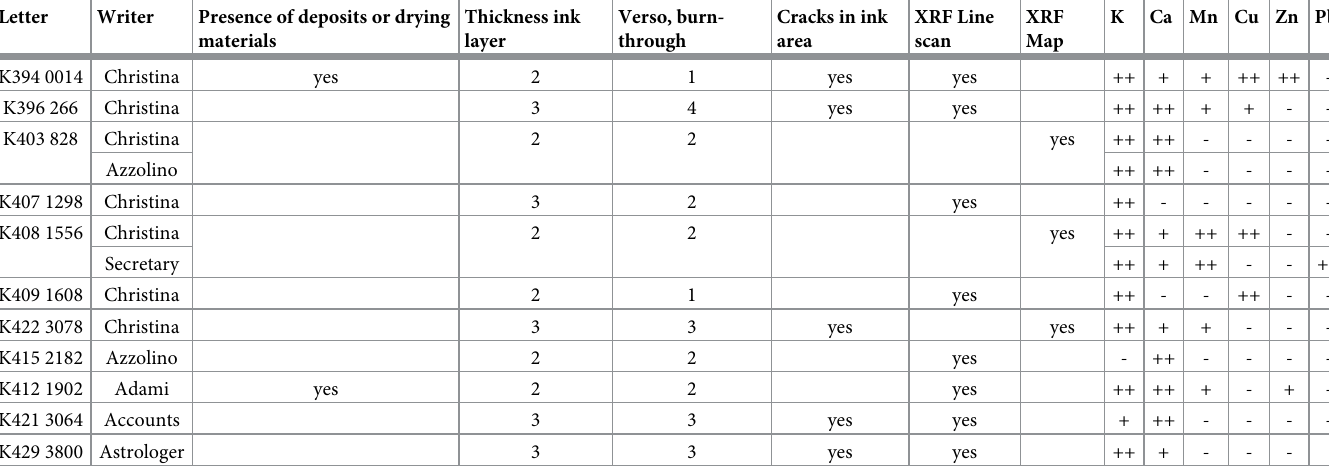
Table 3. Association of elements with ink.